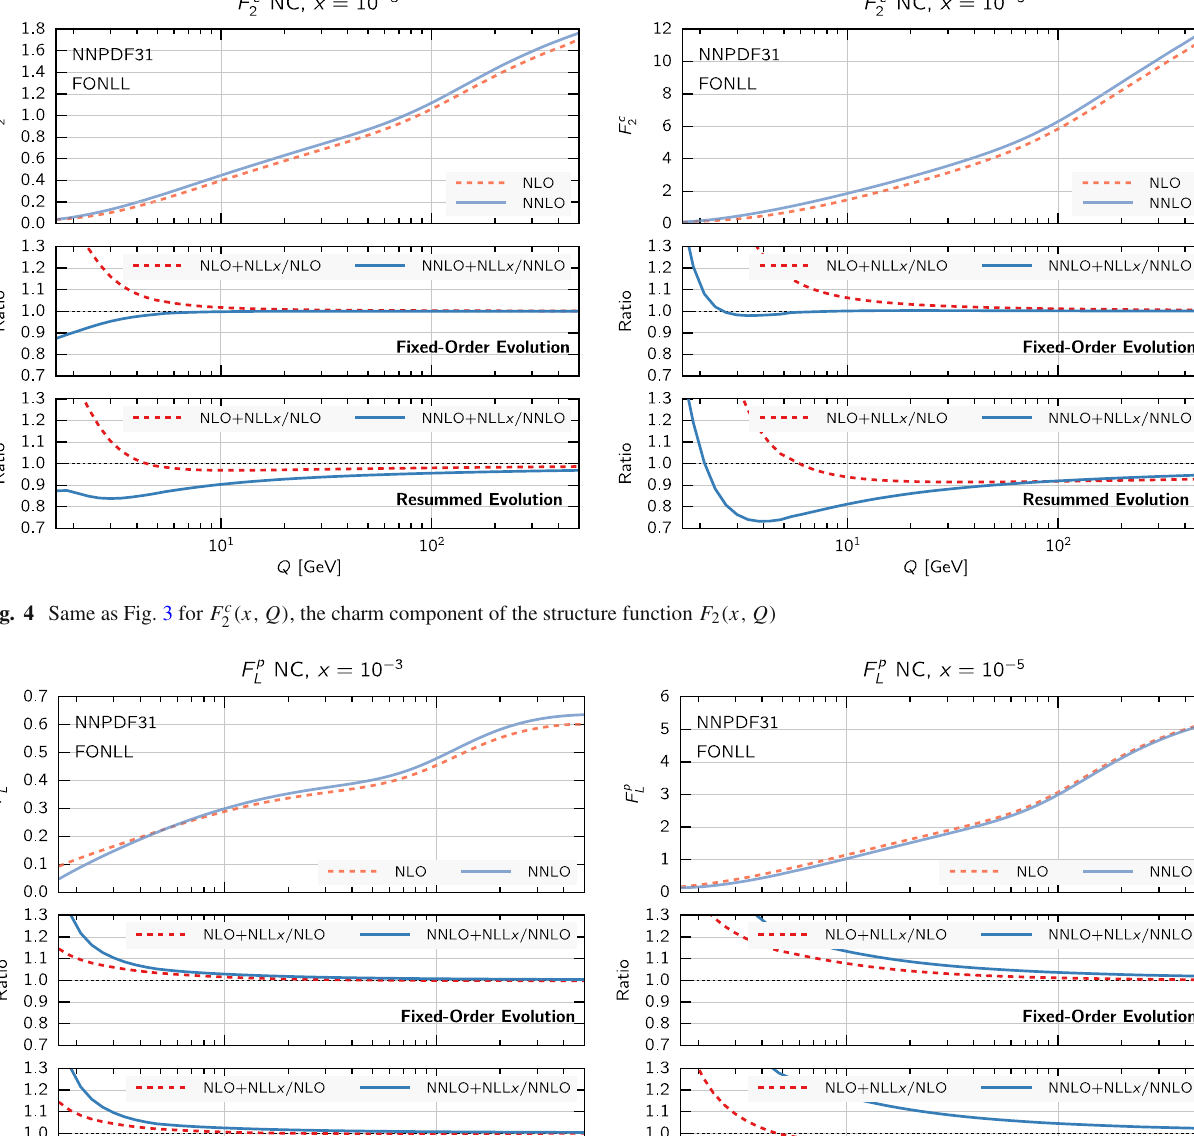
Fig. 5 Same as Fig. 3 for the proton longitudinal structure function F L ( x , Q